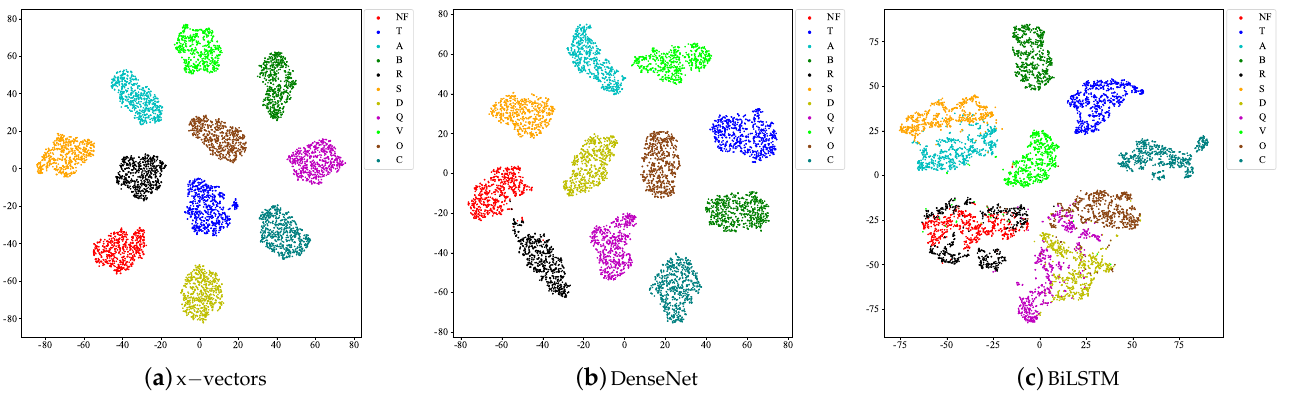
Figure 8. t − SNE images of embeddings for different networks.